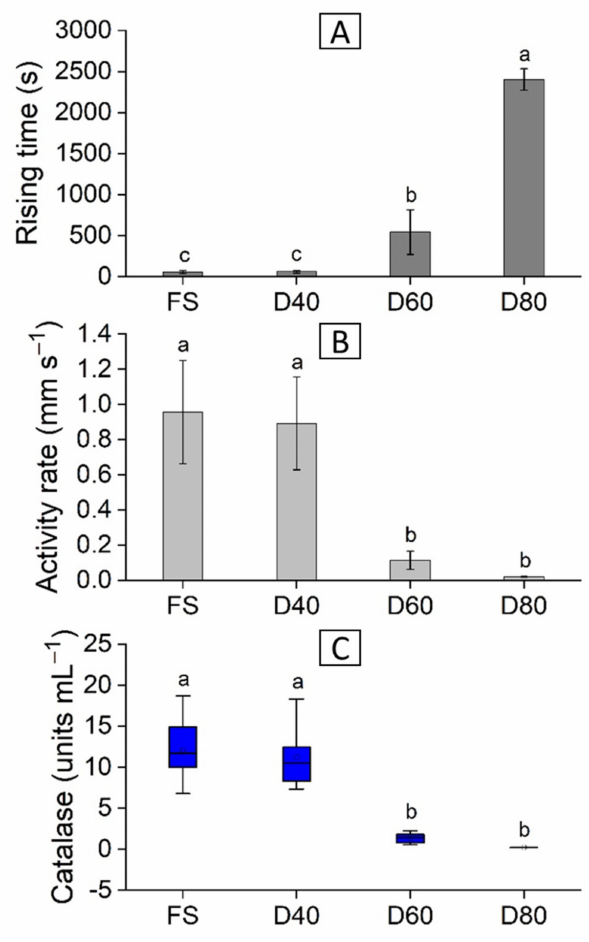
Figure 6. ( A ) Disc rising time (s), ( B ) activity rate (mm s − 1 ) and ( C ) catalase activity (units mL − 1 ) of fresh mango and mango dried at 40 ◦ C, 60 ◦ C and 80 ◦ C. Different letters in a graph represent significant differences at p < 0.05, ( n = 10 ×